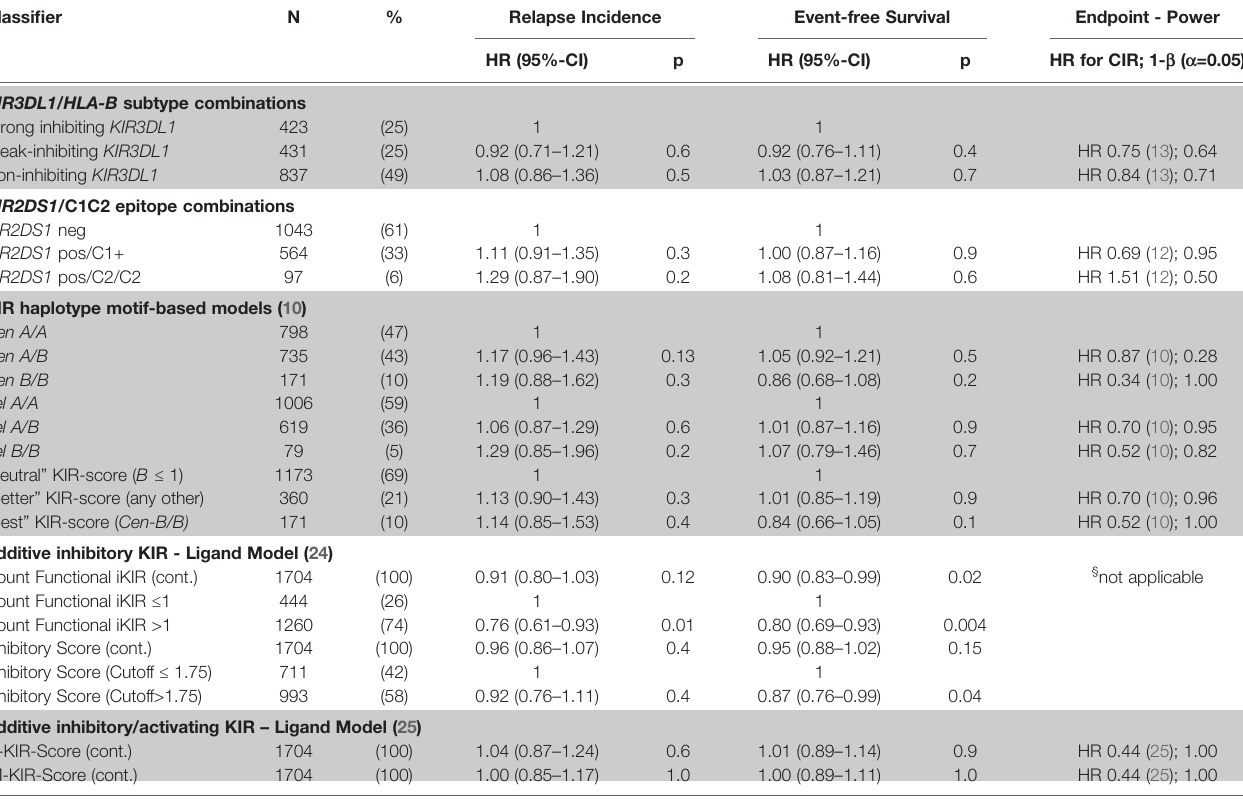
TABLE 2 | Impact of donor KIR genotype models on relapse incidence and event-free